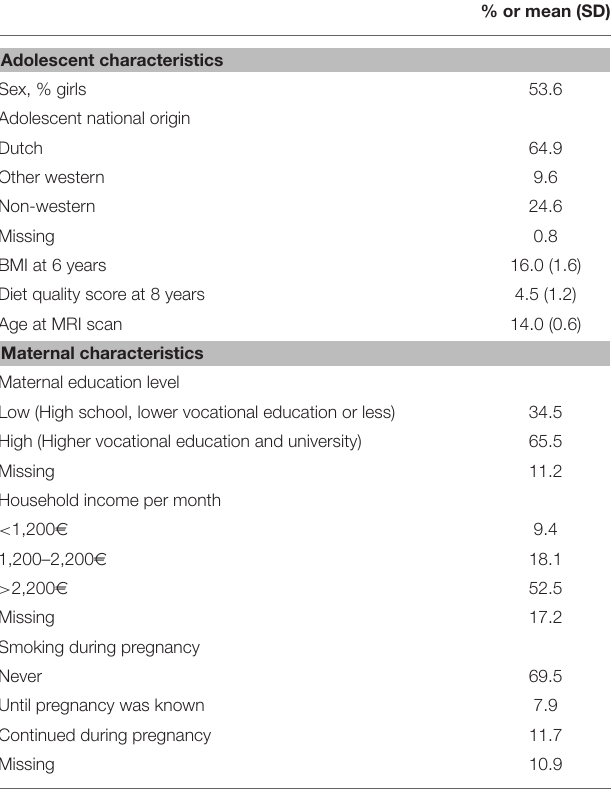
TABLE 1 | Characteristics of the study